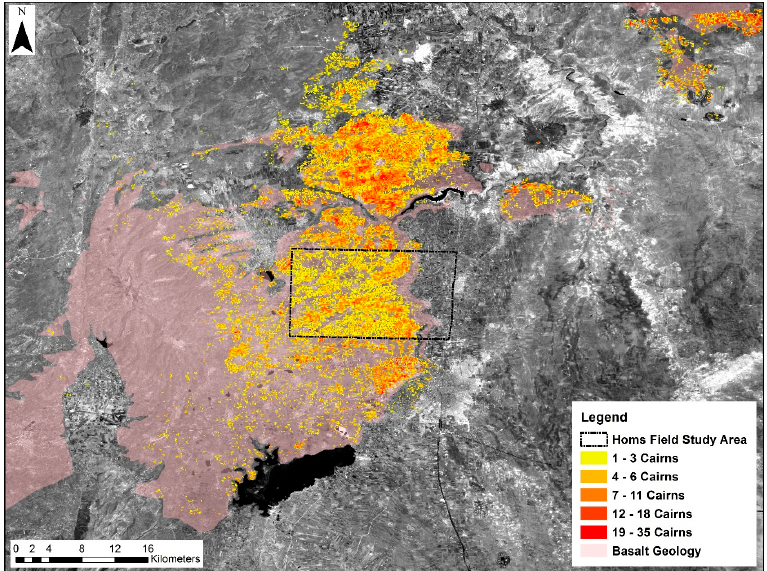
Figure 12. Distribution of cairns identified from remote sensing. Most are found in areas of basalt geology. The area surveyed in the field is indicated by a black rectangle. Cairns are plotted against panchromatic Landsat 7 mosaic (10 April 2005 and 26 June 2007).